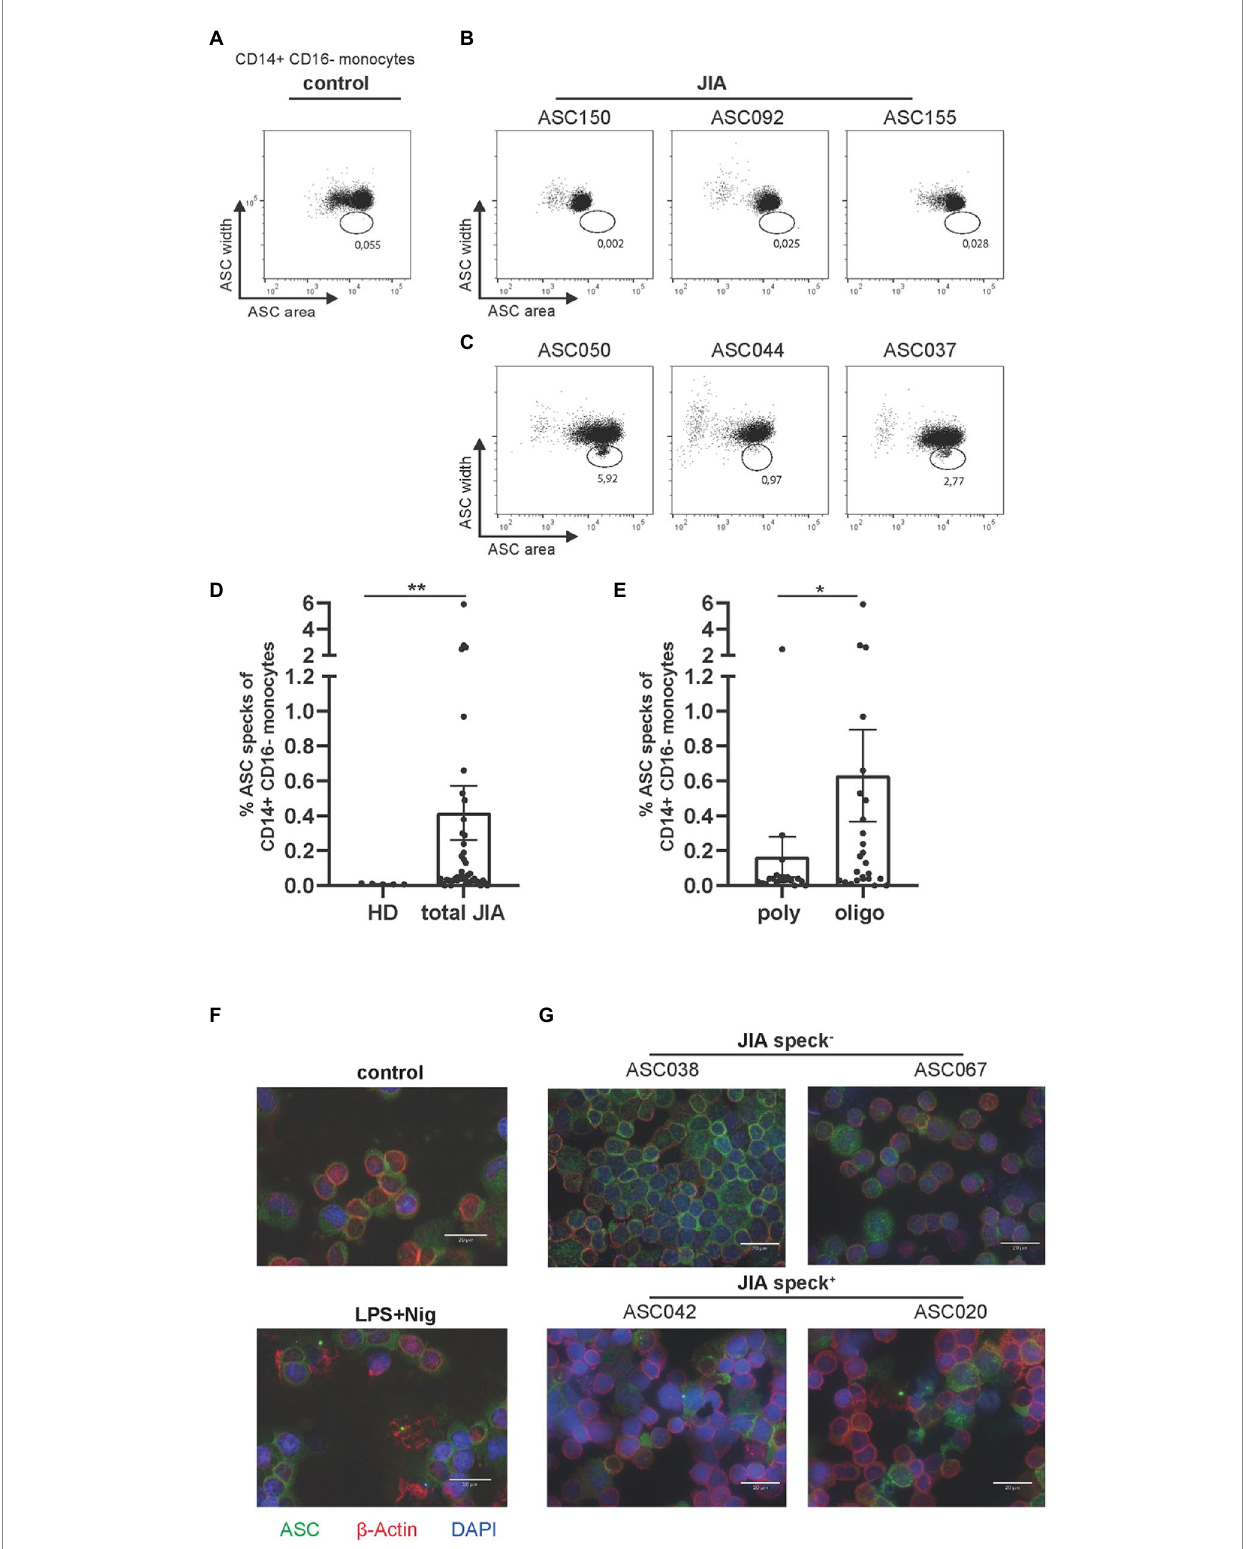
FIGURE 1 Detection of ASC specks in JIA patients, predominantly in the oligo-articular subtype. (A) Representative dot plot of CD14 + CD16 − monocytes from healthy donor. (B,C) Representative dot plots of either ASC speck − or speck + CD14 + CD16 − monocytes ex vivo from JIA patients. (D) Quantification of data from five adult HD and 46 JIA patient samples. (E) Quantification of JIA patients by subtype. (F) Representative fluorescence microscopic images of ASC speck formation in PBMCs from adult HD after stimulation with LPS and Nig or untreated and (G) representative patient samples. ASC (green), β -actin (red) and DAPI (nuclei, blue) (scale bar 20 μ m). (D,E) Mann–Whitney- U -test was performed, shown mean ± SEM. A p -value * p < 0.05; ** p < 0.01 was considered